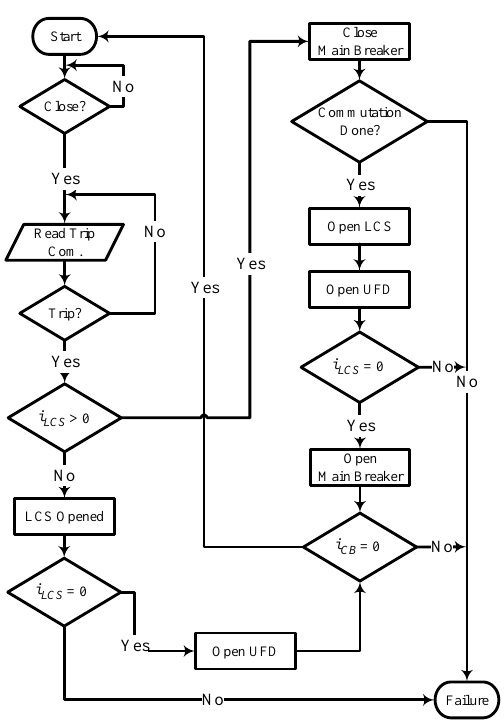
Fig. 14. Unidirectional hybrid DC circuit breaker operation logic flowchart